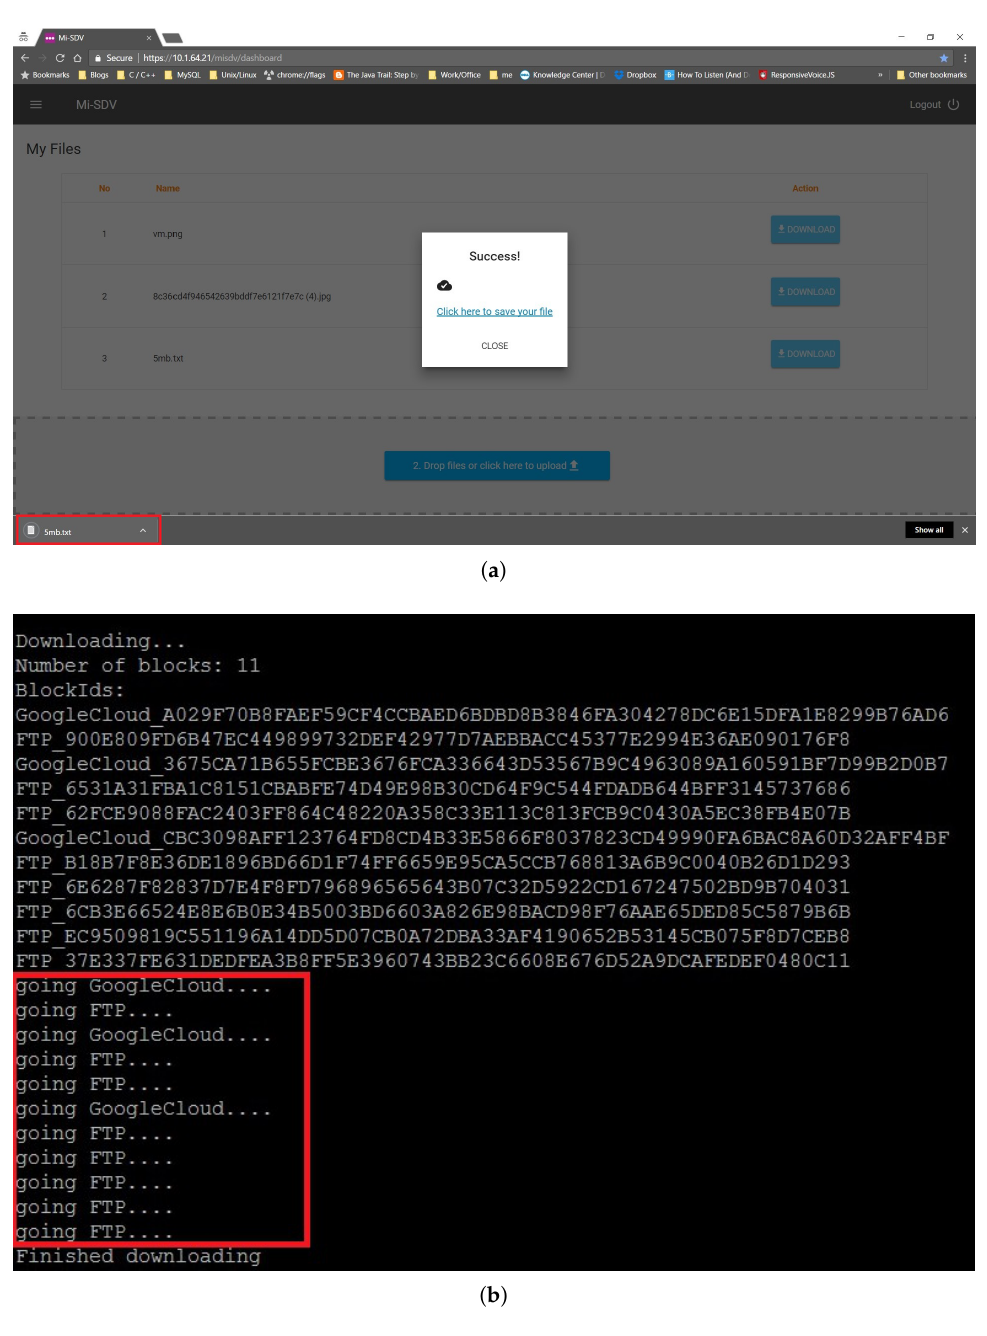
Figure 10. Retrieving a document. ( a ) Downloaded file saved; ( b ) Download: Server log showing block identifiers and retrieval of blocks from Google Drive and local